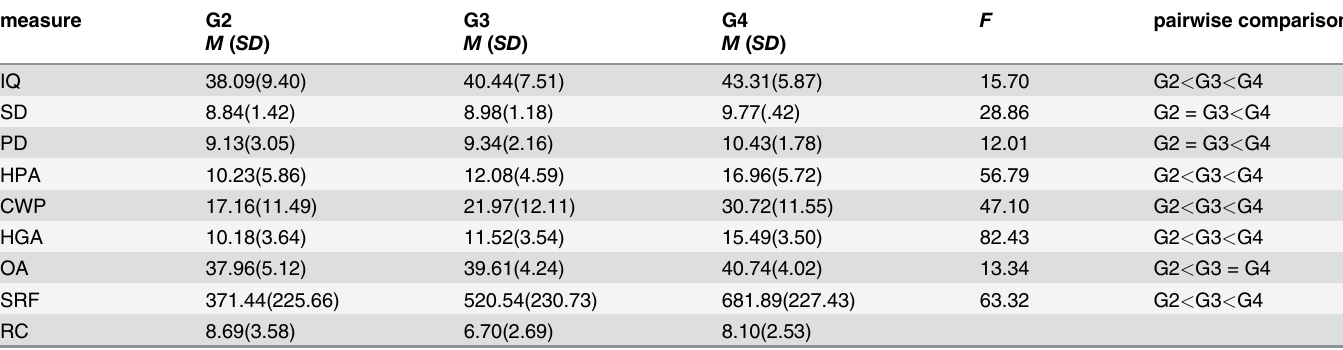
Table 1. Descriptive Statistics for Observed Variables by Grades.